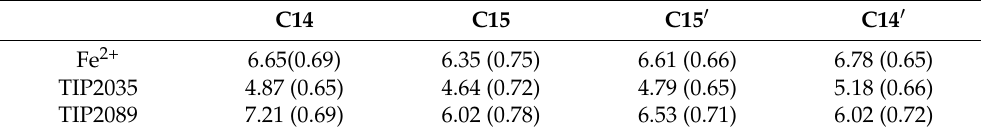
Table 2. Average bond distances (Å) with a corresponding standard deviation of the 14, 15, 15 (cid:48) and 14 (cid:48) atoms of β -carotene to Fe 2+ and water molecules TIP2035 and TIP2089, for